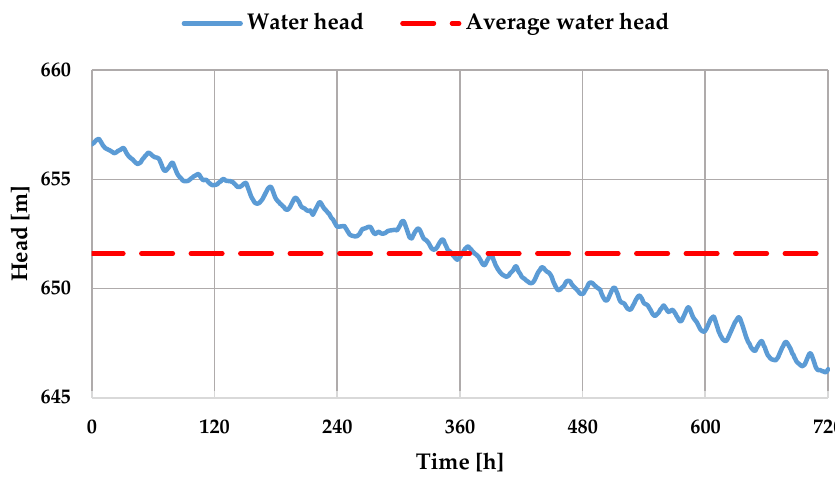
Figure 11. Water head fluctuations over a monthly period.